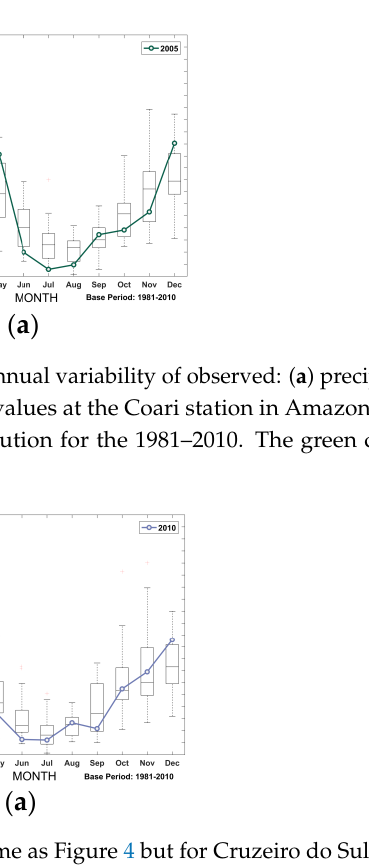
Figure 5. The same as Figure 4 but for Cruzeiro do Sul station in Acre (AC) and for 2010 (blue curve).